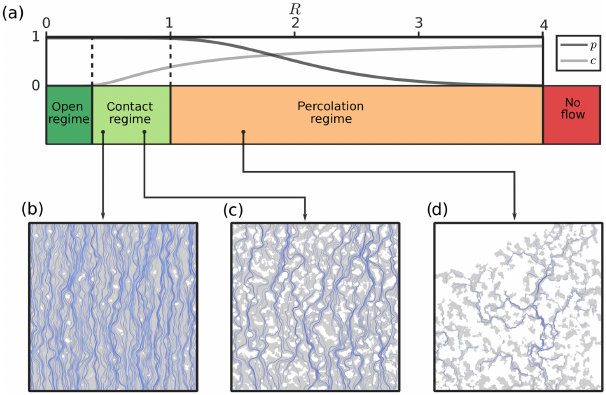
Figure 10. A sketch of the three different closure regimes, indicated as a function of R with corresponding p and c . The lower part of the figure shows three examples of fluid flow simulations from the indi- cated regimes. The gray shaded area is fracture void space, whereas the white regions indicate contact between both surfaces. Blue lines depict chosen streamlines, approximated from the resulting Stokes velocity